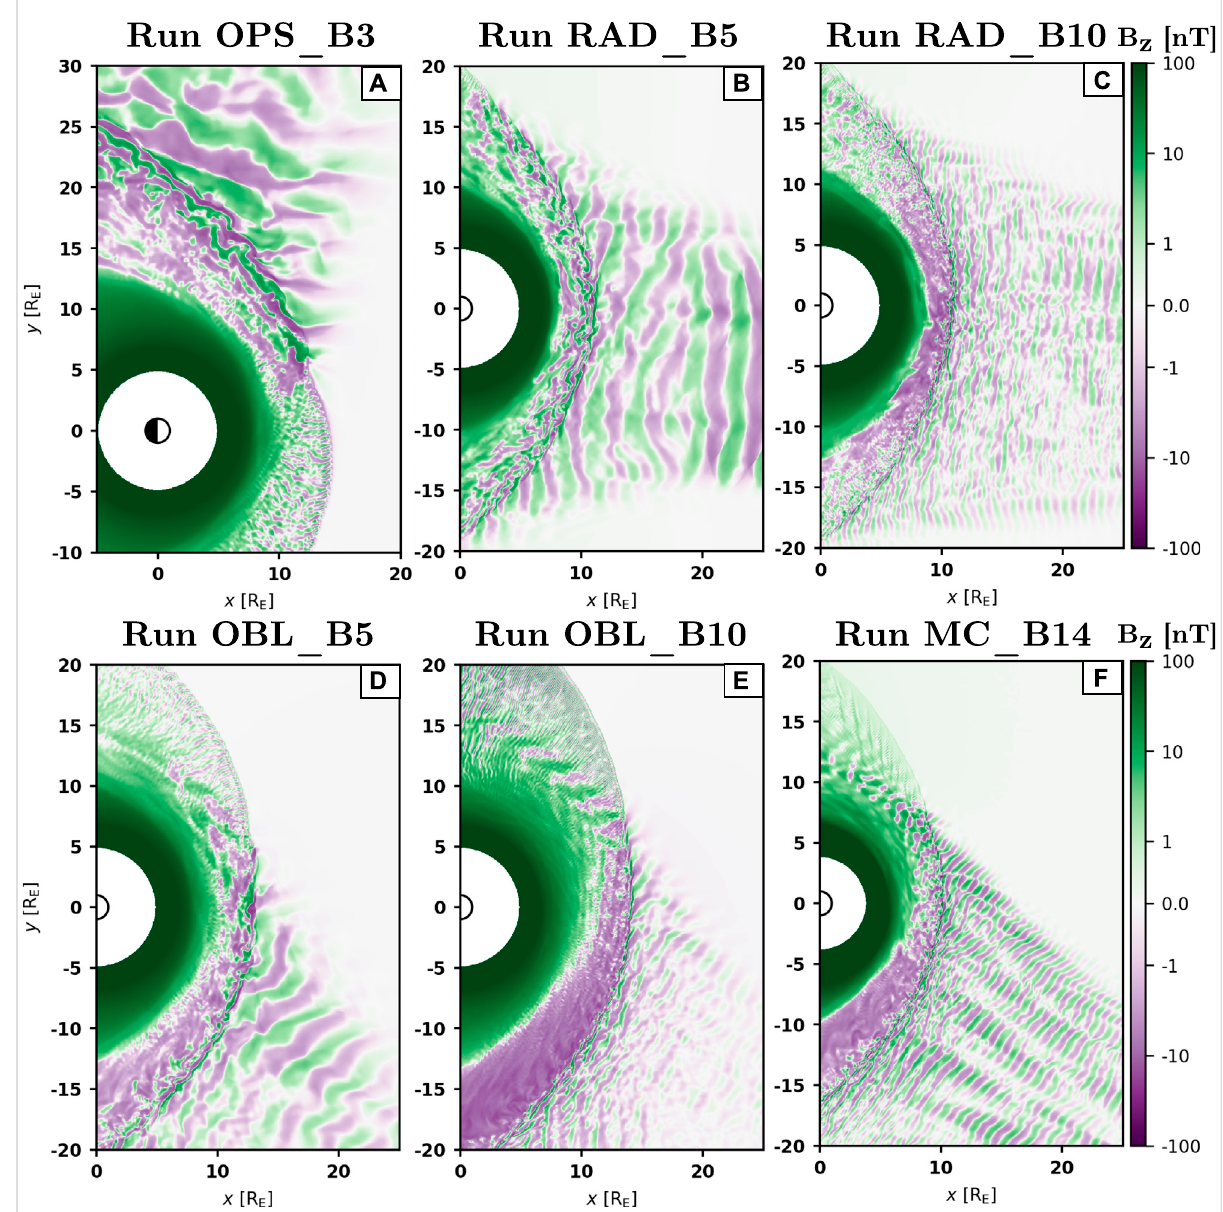
FIGURE 1 B z magnetic fi eld component in the runs under study at t = 500 s from the beginning of the simulation, in a portion of the simulation domain covering the dayside magnetosphere, magnetosheath and part of the foreshock and upstream solar wind. All panels have the same x and y axis extent, but panel (A) has different x and y ranges to better show the